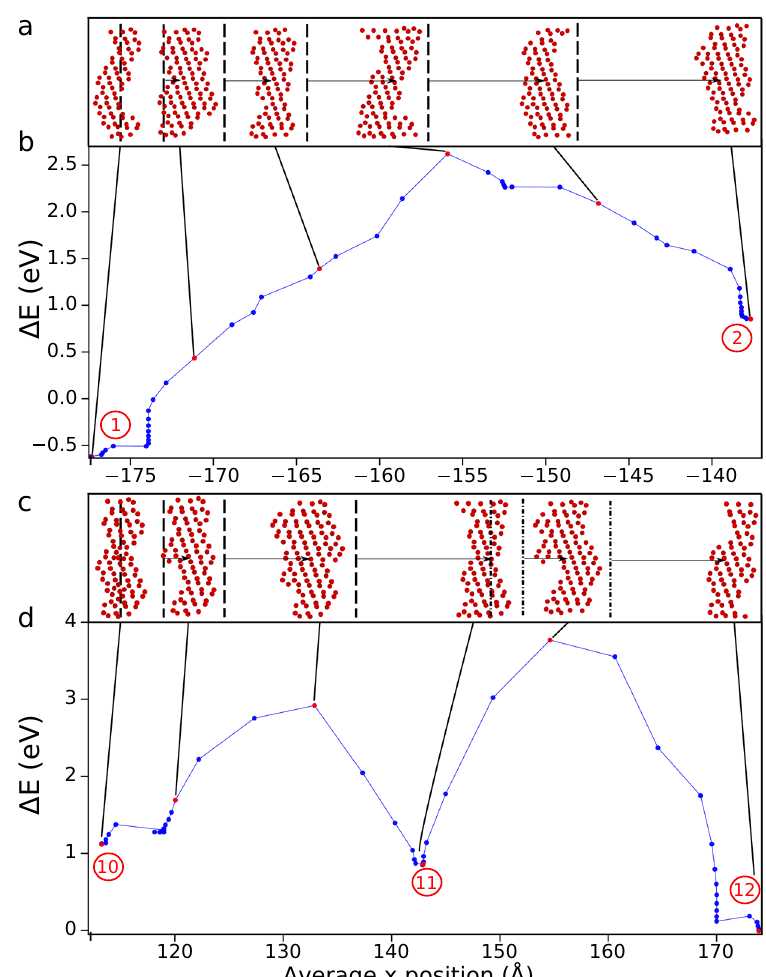
Fig. 4 Energy and shape of an edge dislocation through its minimum energy path in NbTaV. a , c Edge dislocation con fi gurations at several positions along the minimum energy paths, with the dashed lines indicating the original position of the minima to show the glide distance clearly. b , d Minimum energy paths (energy versus mean dislocation position) for the dislocations moving from one minimum to the next in one region of the true random alloy. The labels can be matched with those in Figs. 2 and